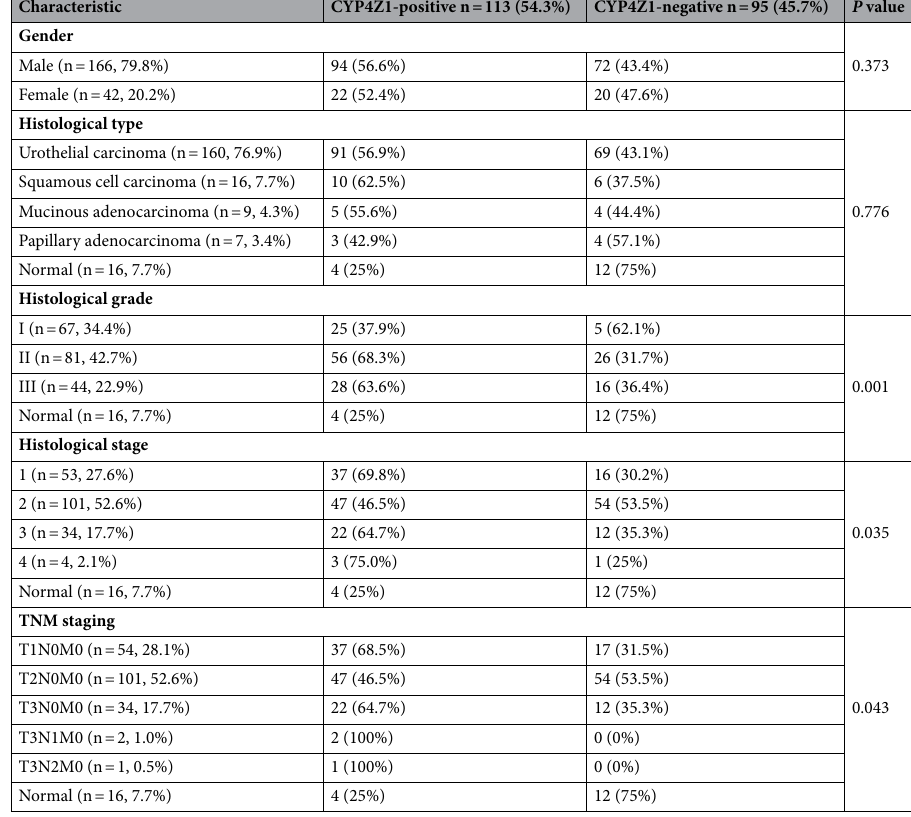
Table 1. Association between CYP4Z1 expression and clinicopathologic